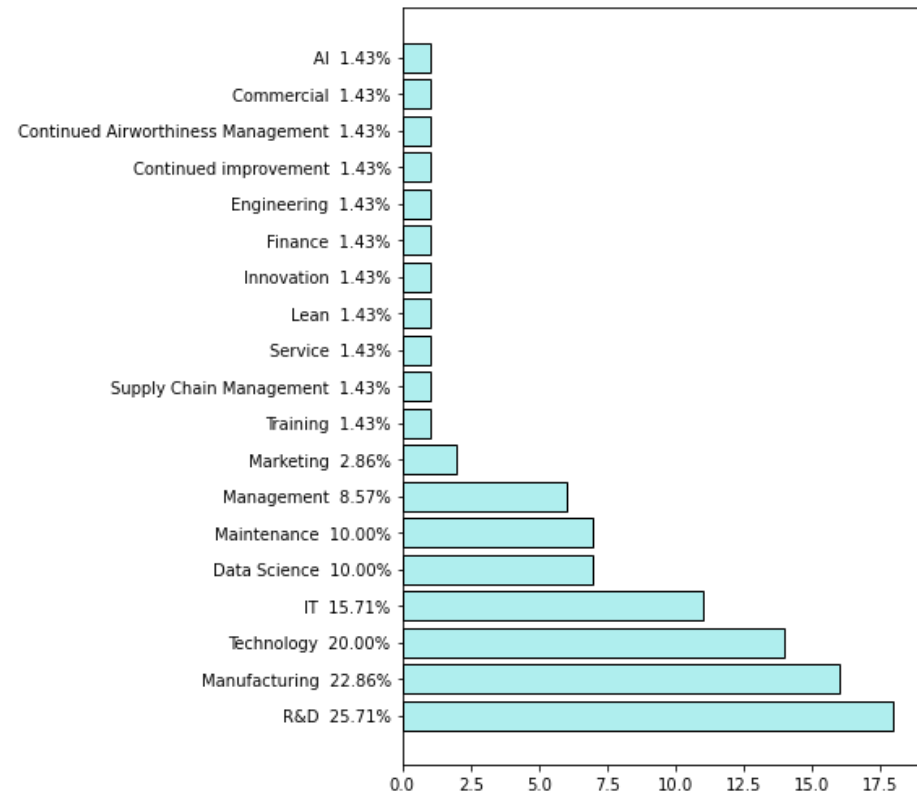
Figure 7. Number of production sites (details).